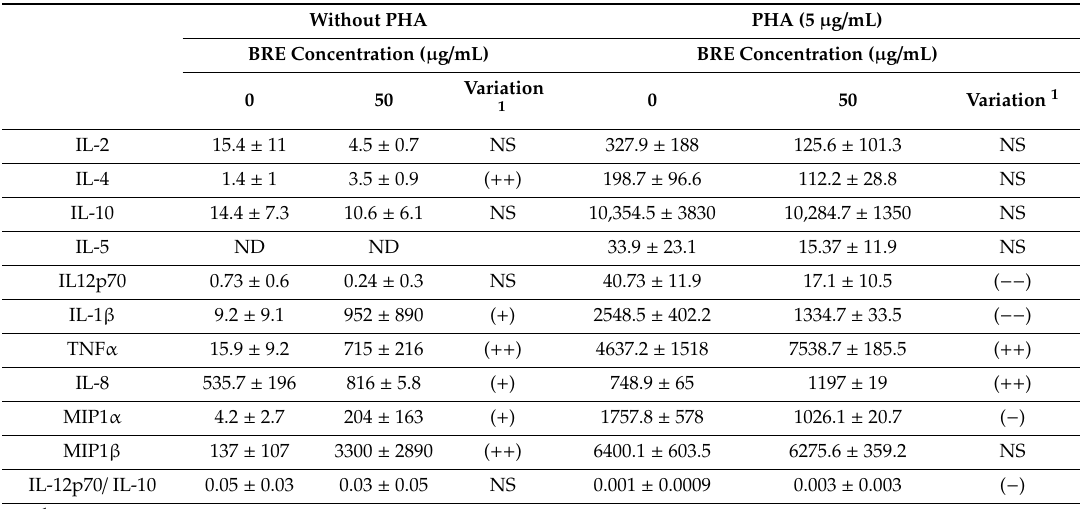
Table 4. BRE impacted cytokines secretions of PBMCs. Cells were incubated with BRE as indicated and stimulated with PHA (5 µ g / mL) for 24 h. Data were shown as means ± SD (pg / mL); ND: not detected. Without